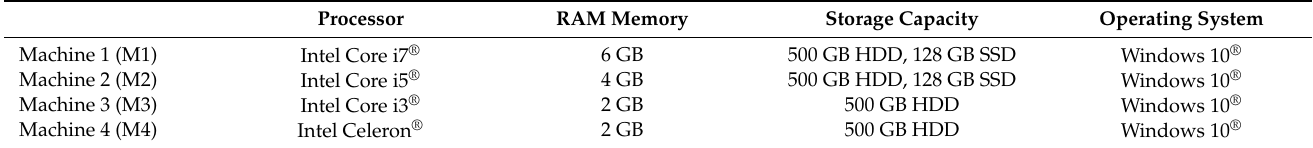
Table 7. Specification of testing